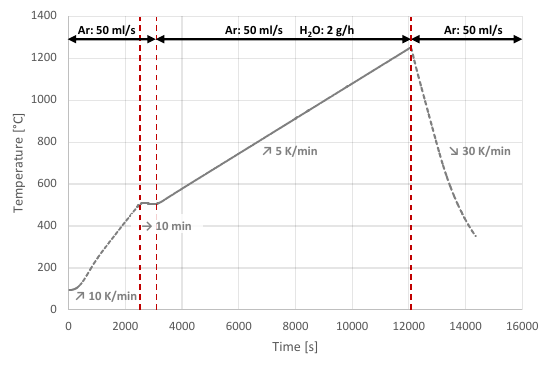
Figure 3. The transient experiment was cooled down to 100 °C with the cooling rate of 5 K/min. The isothermal experiments were performed at the temperatures of 700 °C, 800 °C, 900 °C, 1000 °C, 1100 °C and 1200 °C.